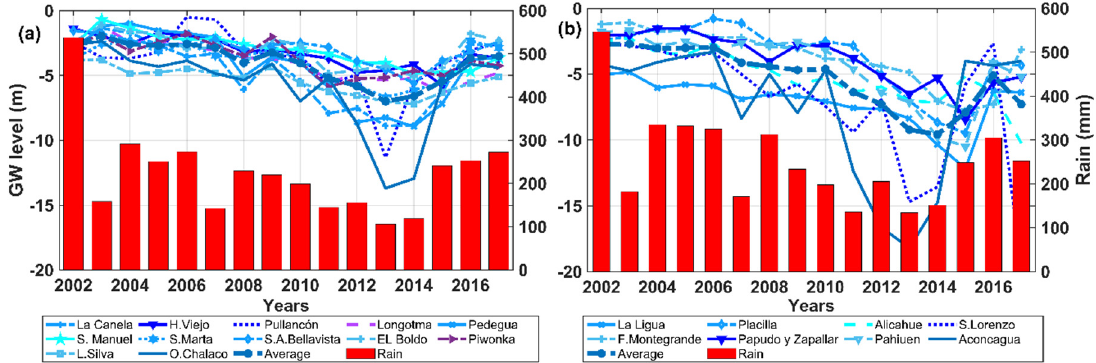
Figure 4. Annual average GW level by well and watershed and annual average rainfall in ( a ) Petorca watershed and ( b ) Ligua watershed from 2002–2017.